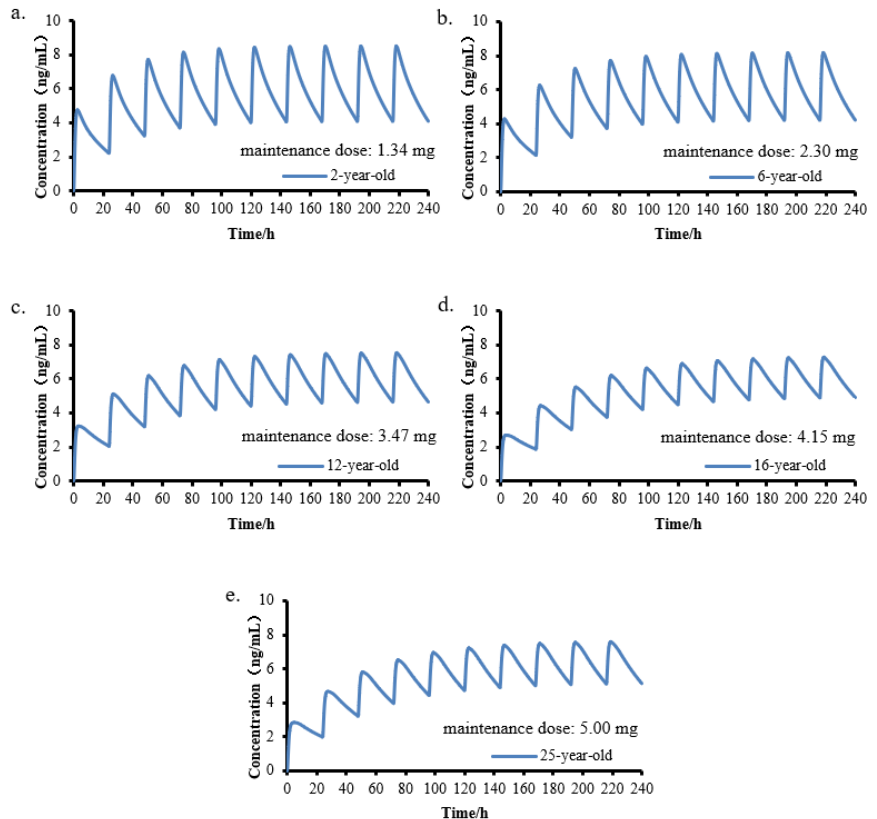
Figure 5. The curve simulation diagram of continuous administration for 240 h in different age groups. ( a ). Simulation 1, a child aged 2 years old, 1.34 mg, q.d.; ( b ). Simulation 2, a child aged 6 years old, 2.30 mg, q.d.; ( c ). Simulation 3, a child aged 12 years old, 3.47 mg, q.d.; ( d ). Simulation 4, a child aged 16 years old, 4.15 mg, q.d.; ( e ). Simulation 5, an adult aged 25 years old, 5.00 mg, q.d.).